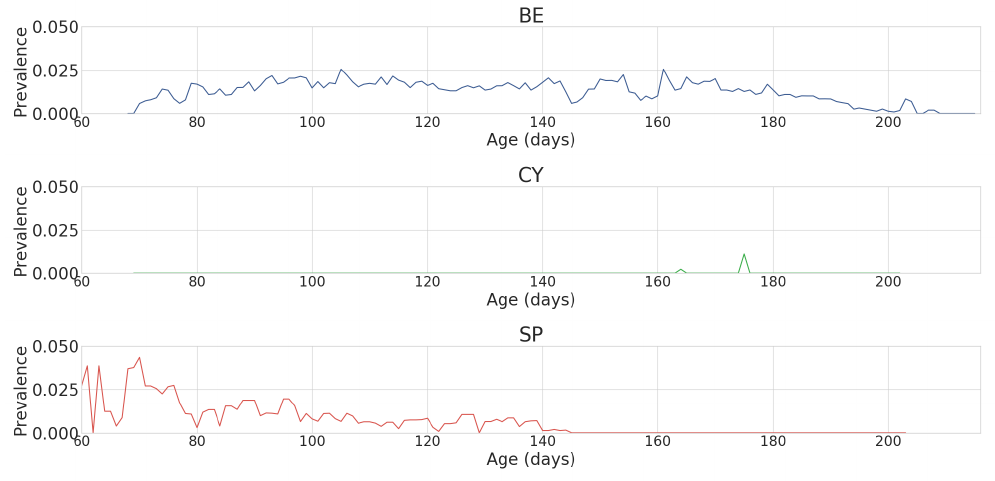
Figure 3. A graph showing the average prevalence of respiratory disease against age (in days) in all batches of growing pigs in Belgium (BE), Cyprus (CY), and Spain (SP) after